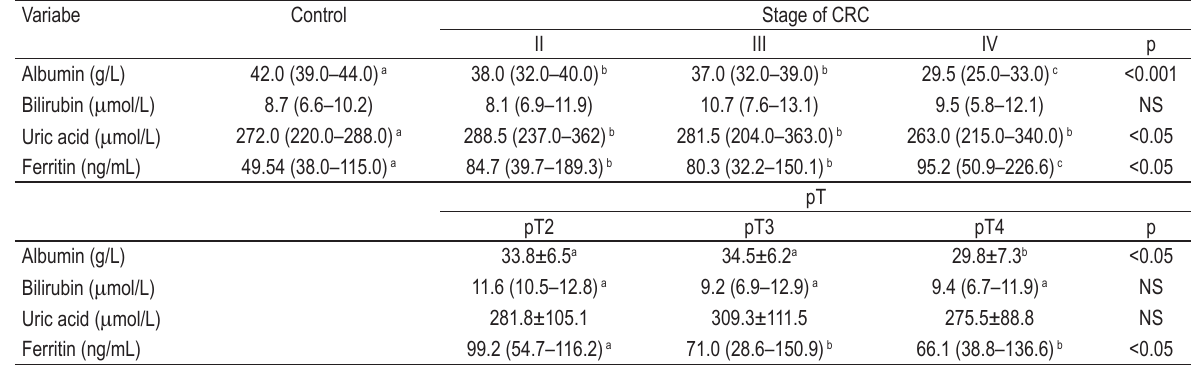
TABLE 2. The serum concentration of non-enzymatic antioxidants in relation to the stage and histopathological features of CRC Variabe Control